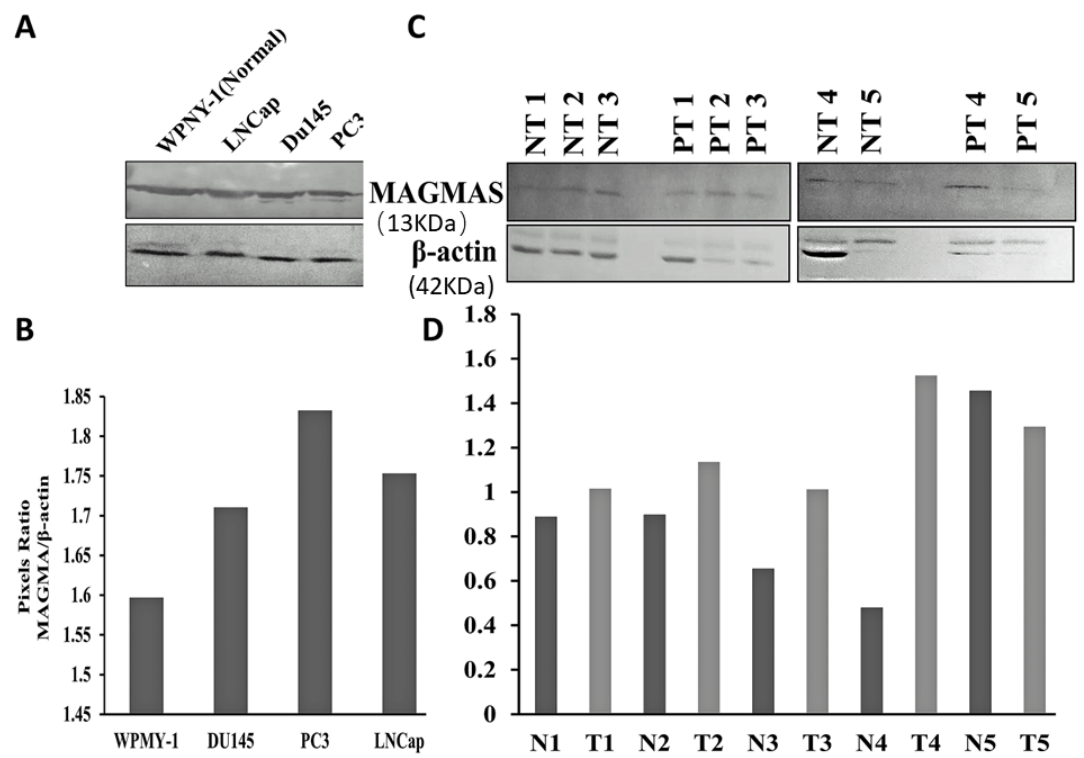
Figure 1. Magmas is overexpressed in prostate cancer cell lines and prostate tumor tissues. ( A ) Rep- resentative immunoblot showing Magmas protein expression in WPMY-1 (the EBV-transformed prostate/stromal cell line) and LNCaP, DU145 and PC3 prostate cancer cell lines. β -actin was used as loading control. ( B ) The intensity ratio of Magmas protein/ β -actin for WPMY-1, LNCaP, DU145 and PC3 cell lines. ( C ) Representative immunoblot showing Magmas protein expression in five normal prostate cancer adjacent tissues (NT1-NT5) and prostate tumor tissues (PT1-PT5). β -actin was used as loading control. ( D ) The intensity ratio of Magmas protein/ β -actin) for the five normal prostate cancer adjacent tissues (NT1-NT5) and the five prostate tumor tissues biopsies (PT1-PT5).